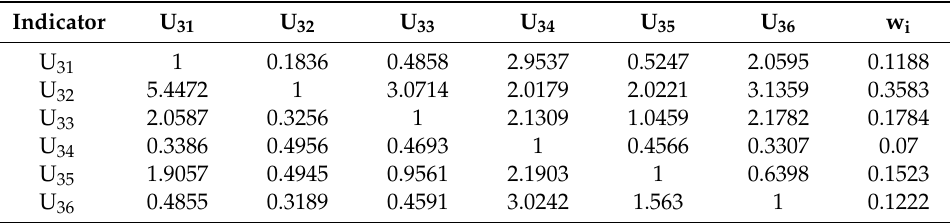
Table 7. Revised matrix of social benefit